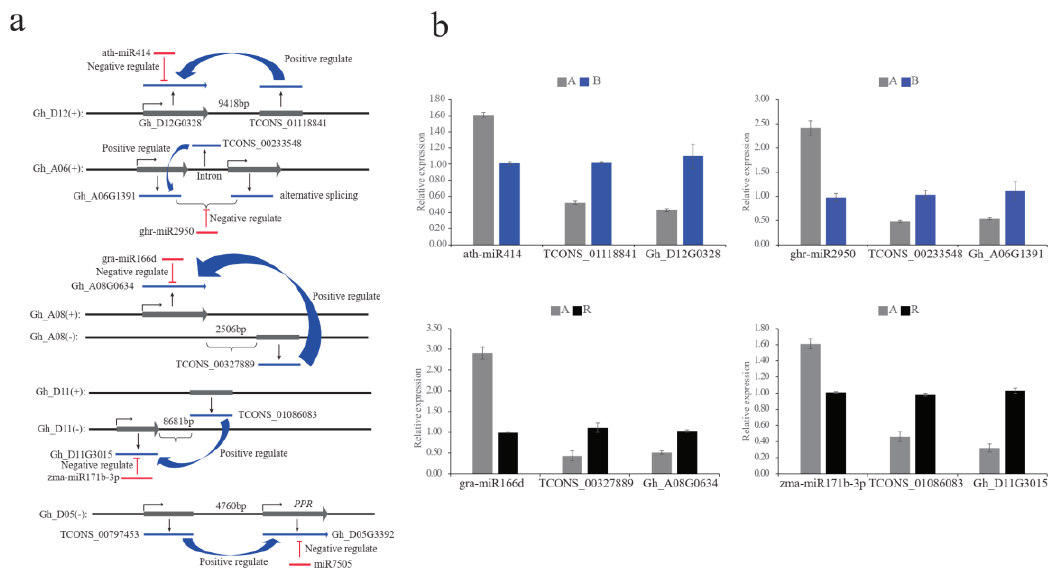
Figure 7. The putative regulation mechanism and expression pattern analysis in miRNAs–lncRNAs– mRNAs networks during anther development. ( a ) Regulation mechanism prediction of functional miRNAs–lncRNAs–mRNAs networks in anther development; ( b ) The qRT-PCR validate four miRNAs–lncRNAs–mRNAs regulatory networks in anther development of